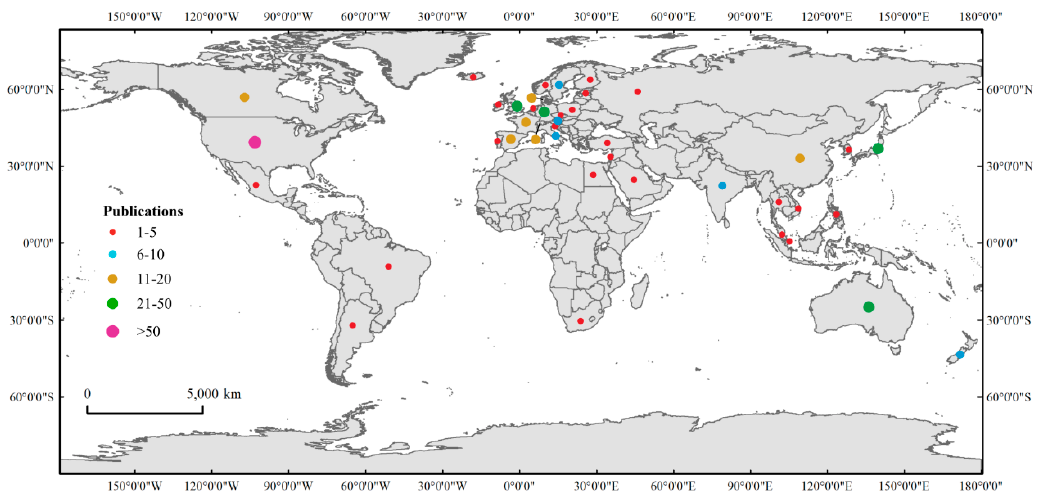
Figure 3. The worldwide distribution map of research on the use of eDNA with eutrophication and HABs from 1975 to 2020 (2nd March) based on publications from Web of Science.